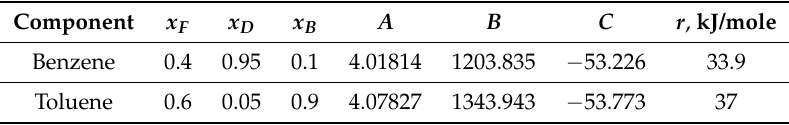
Table 1. Data for Example